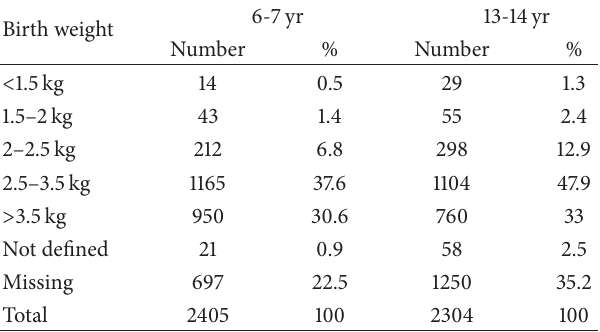
Table 1: Distribution of birth weight in age